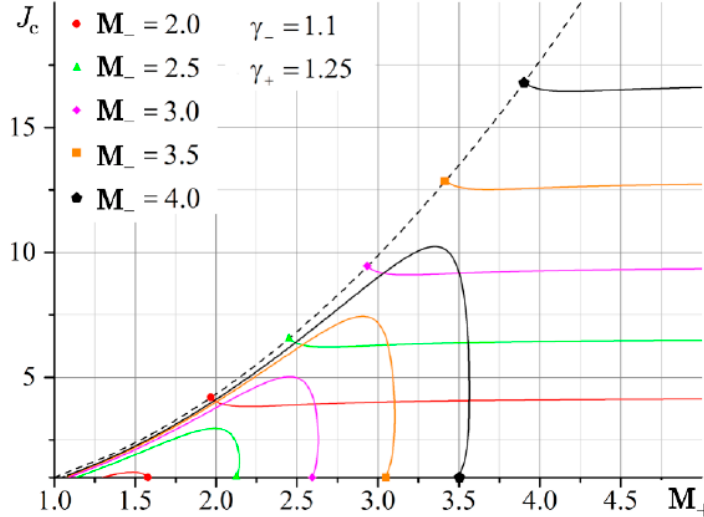
Figure 8. Dependence of the intensity J c of the incident shock corresponding to the characteristic refraction on the Mach numbers M – and M + in flows separated by a tangential discontinuity. The dotted line shows the dependencies corresponding to the case when the refracted shock has the maximum intensity J 2 ﹦ J m .